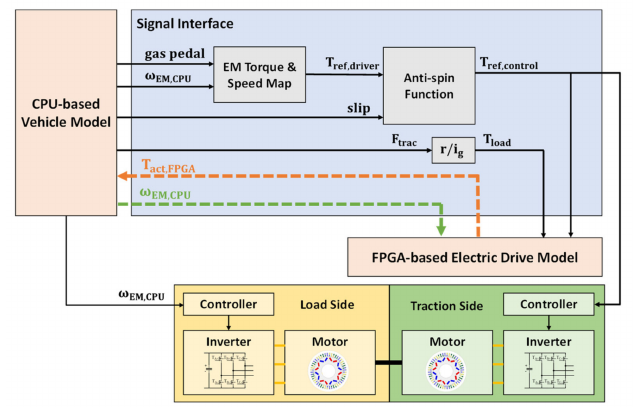
Figure 14. Experimental interface between the real-time simulator and the test